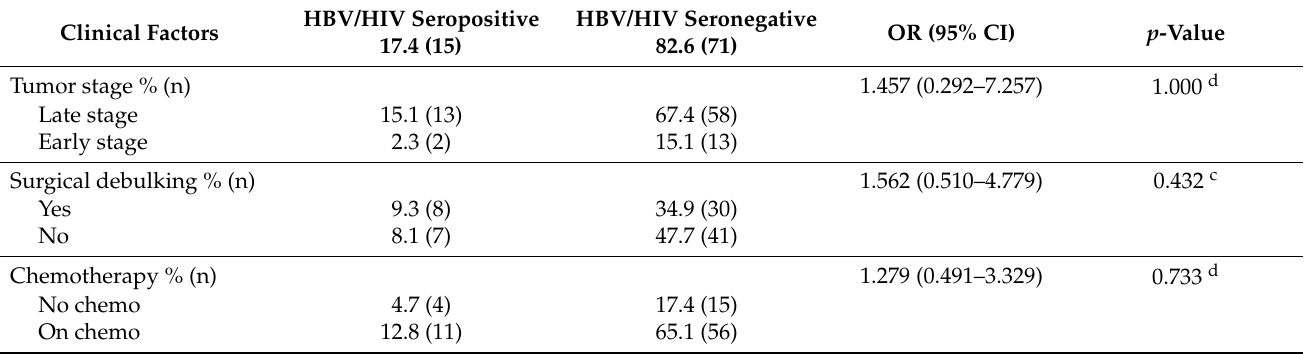
Table 6. Association of ovarian cancer patients’ HBV/HIV coinfection status with the clinical